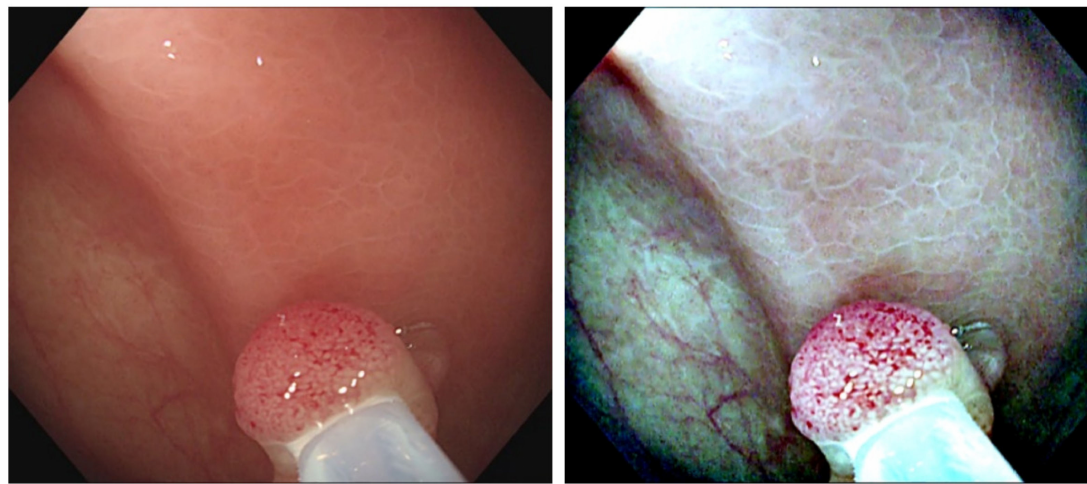
Figure 5. Images of TA polyp after Retinex. (( Left ): Original WL, ( Right ):